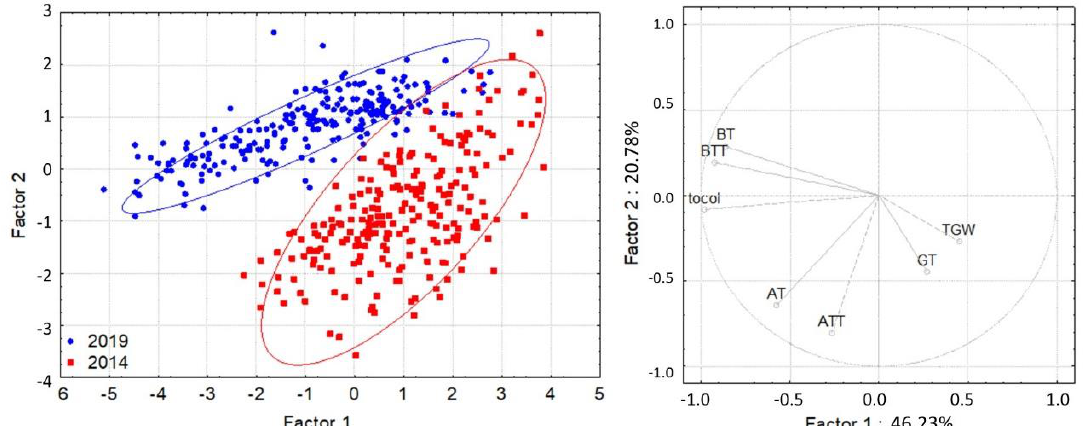
Figure 1. Principal component analysis based on the content and composition of tocols in the grain. AT = α -tocopherol, ATT = α -tocotrienol, BT = β -tocopherol, BTT = β -tocotrienol, GT = γ -tocopherol, tocol = total tocol content, and TKW = thousand-kernel weight (where the most determinant traits contributing to Factor 1 were BT ( − 0.8607), BTT ( − 0.9239), and tocol ( − 0.9814), while it was AT ( − 0.6417) and ATT ( − 0.8032) for Factor 2).